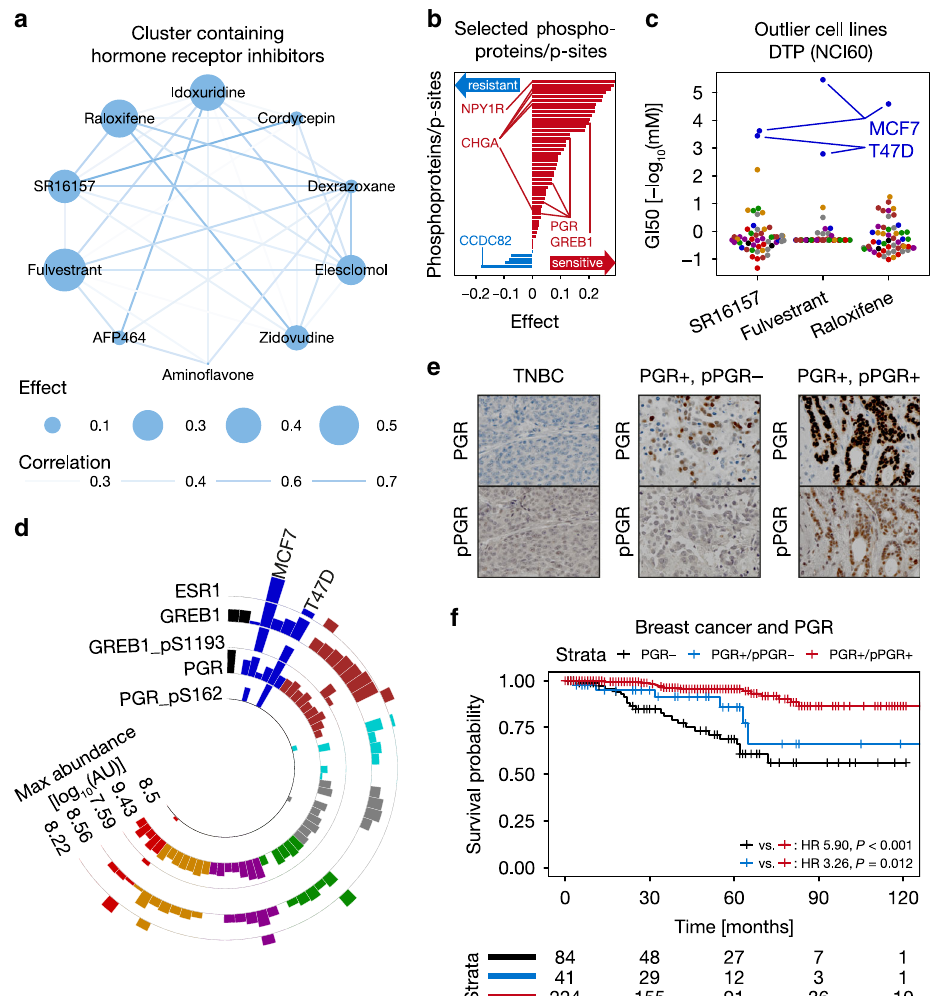
Fig. 6 High phosphorylation of PGR predicts bene fi t from endocrine therapy in breast cancer. a Cluster containing several hormone-receptor